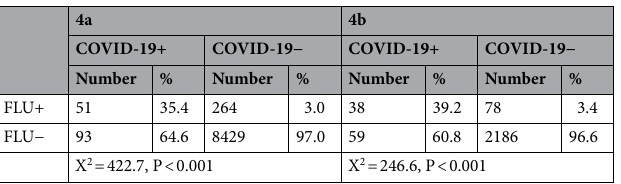
Table 4. Cross tabulation table for COVID-19 and FLU positivity (4a: all age, 4b: 20 s).